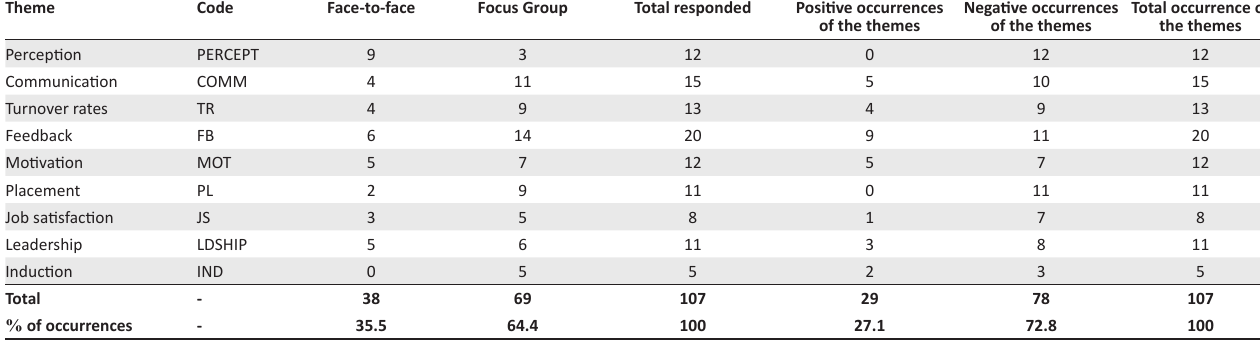
TABLE 7: Quantified qualitative outcomes of themes for Cluster 2: Human factors.